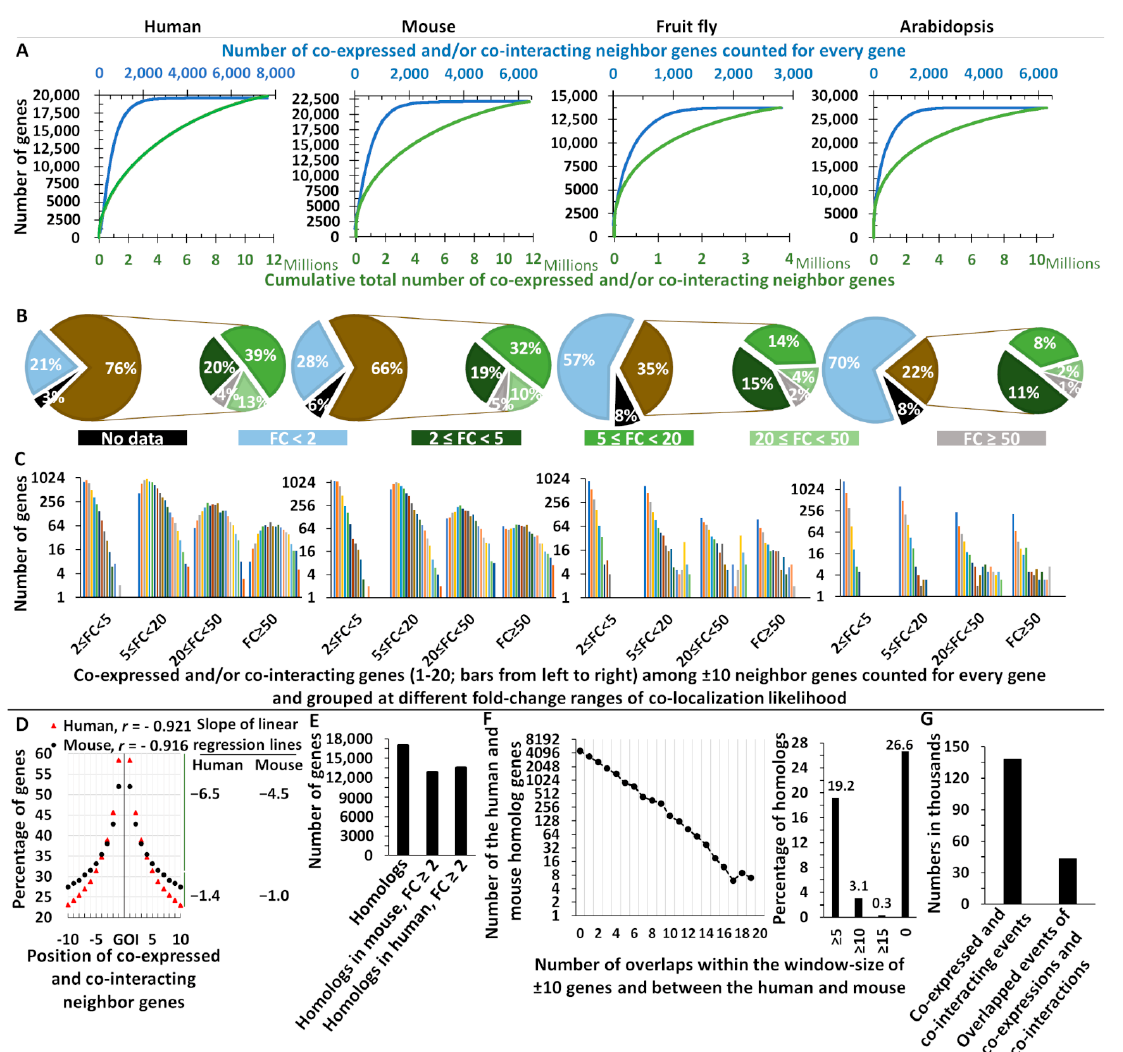
Figure 1. Genome-wide trends in co-localization of co-expressed and co-interacting genes. ( A ) Number of co-expressed and co-interacting genes counted for every gene. The blue color is for the total number and the green color is for the cumulative number of events. ( B ) Percentage of genes with different fold-changes in likelihoods of co-localization with co-expressed and co-interacting partner genes. For every gene, the co-localization likelihood, i.e., the observed likelihood for co-expressed and co-interacting gene(s) located among the ± 10 neighbor genes, was compared to its observed genome-wide likelihood of co-expressed and co-interacting genes, and fold-changes of ≥ 2 were considered as non-random distributions (see the methods). Homologs and duplicated events were excluded from the analyses. ( C ) Genes with co-localization likelihood fold-change of ≥ 2 had 1–20 co-expressed and co-interacting partner genes within the genomic window size of ± 10 genes. ( D ) The co-localization likelihood of co-expressed and co-interacting genes across the inter-loci distances. GOI is the gene of interest and represents every gene in the genome. ( E ) Homolog genes between the human and mouse with co-localization likelihood fold-change of ≥ 2. The analyses were based on 16,974 homologs, and 254 homologs with missing data were excluded. ( F ) The frequency of overlapped co-expressed and co-interacting neighbor genes with identical physical gene order positions when comparing the human and mouse. The analyses were based on the 16,974 homolog genes between the human and mouse and within the genomic window size of ± 10 genes from the homolog genes. ( G ) Total number of neighbor events and the number of overlapped neighbor events with identical physical gene order positions, both within the genomic window size of ± 10 genes from the homolog genes, when comparing the human and mouse. ( E – G ) To exclude the effect of possible segmental inversions and differences in chromosomal orientations between the human and mouse, inverted but exactly same events were extracted and included in the analyses as overlapped events. FC: Fold change in the co-localization likelihood against the genome-wide likelihood, GOI: gene of